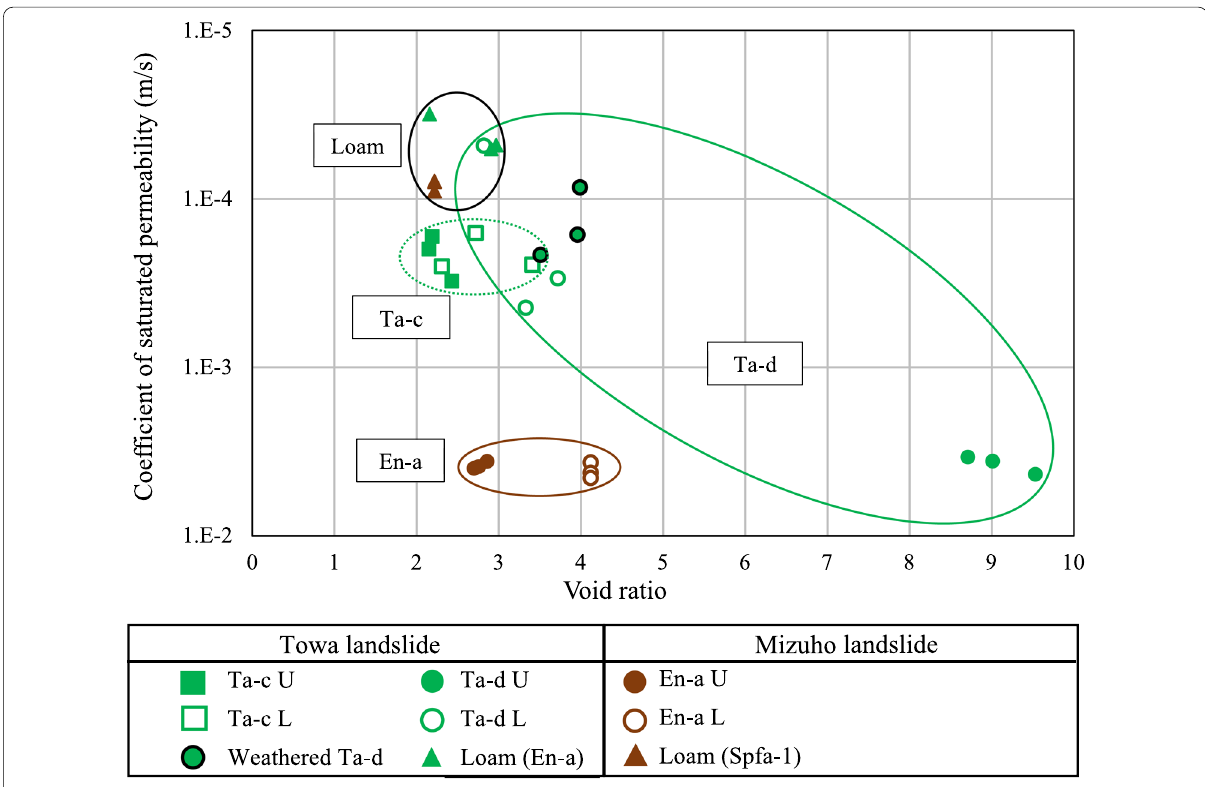
Fig. 8 Correlation between coefficient of permeability (m/s) and void